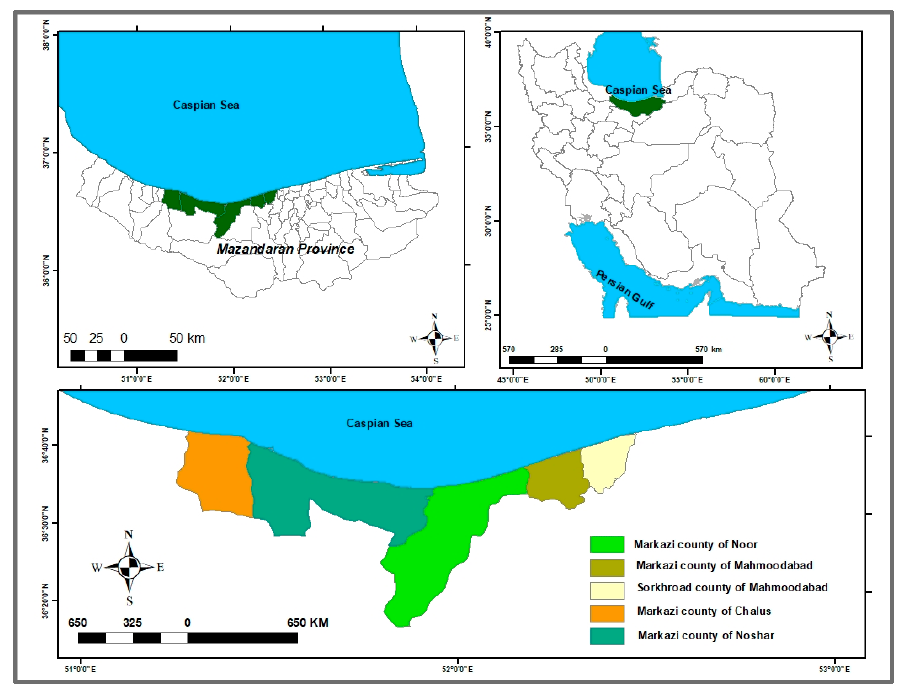
Figure 1. Geographical location of the studied counties in Iran and Mazandaran Province.